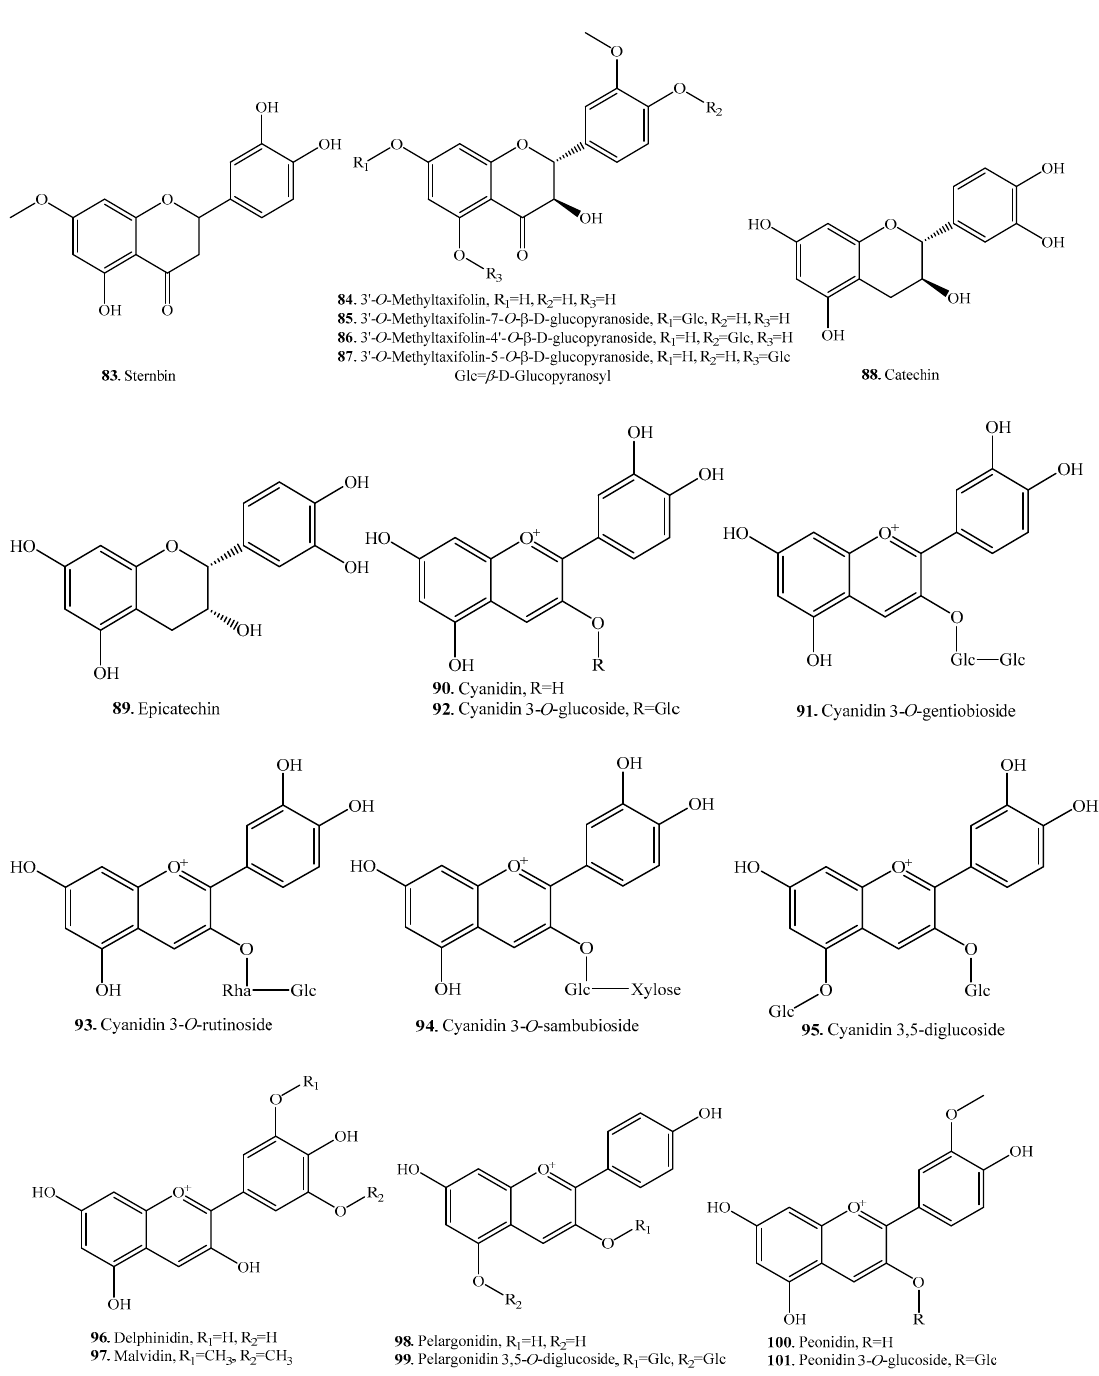
Figure 2. Structures of the flavonoids isolated from rice.